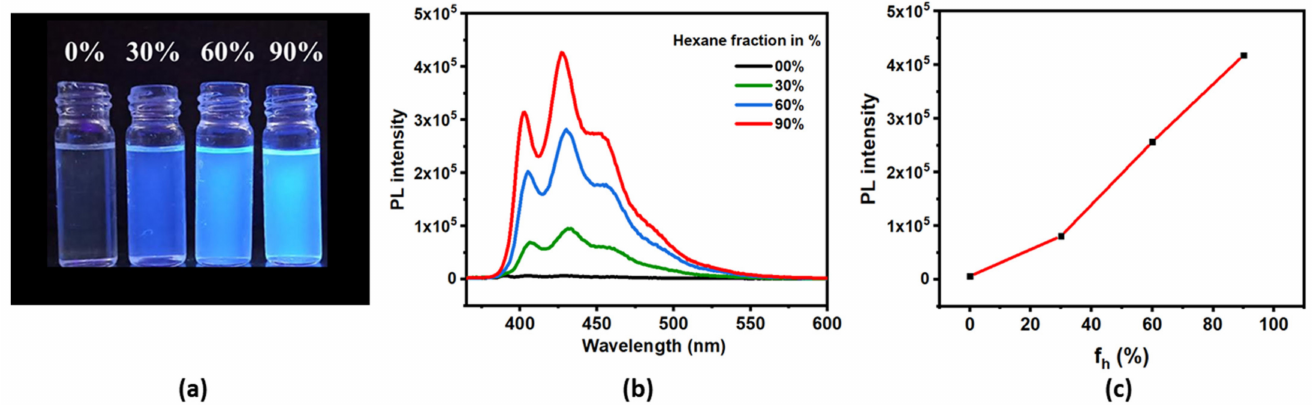
Figure 1. ( a ) Photograph of M1 in THF: hexane mixtures of various hexane fractions (f h ) in percentage (%) under UV lamp (365 nm); ( b ) PL spectra for the same under excitation of 360 nm wavelength; ( c ) Line plot for the changes in PL intensity for M1 with gradual increasing hexane percentage (f h ) in THF: hexane